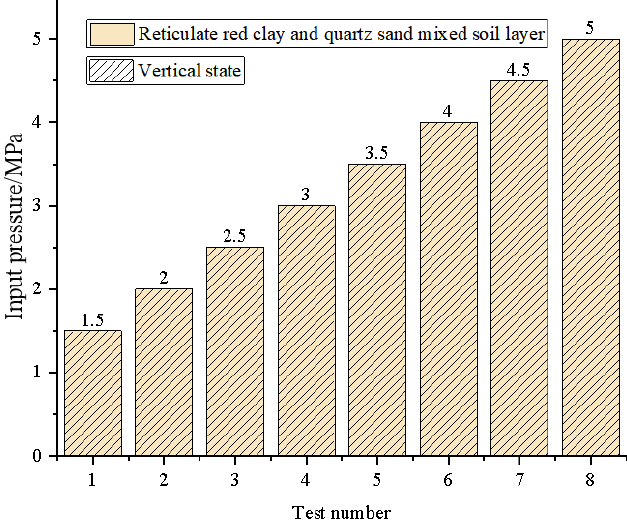
Figure 8. Working state of the C-DP drilling rig. ( a ) Flow Chart; ( b ) Physical drawing.